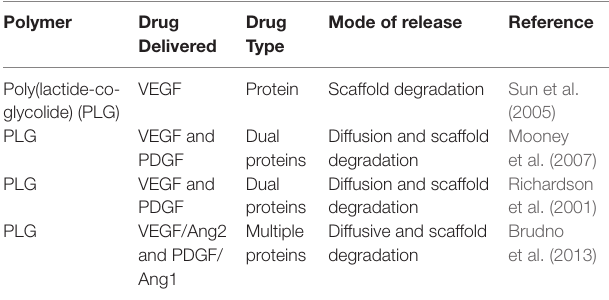
TABLe 4 | Scaffold-based biomaterials for controlled drug